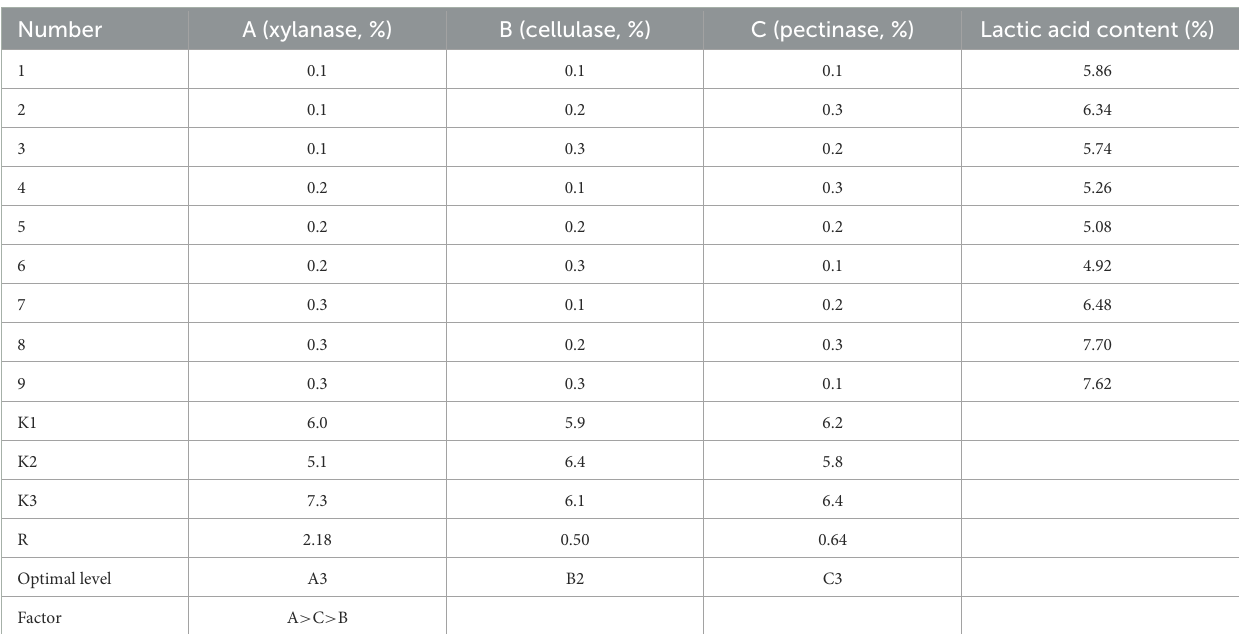
TABLE 2 Orthogonal test on enzyme addition for optimization of